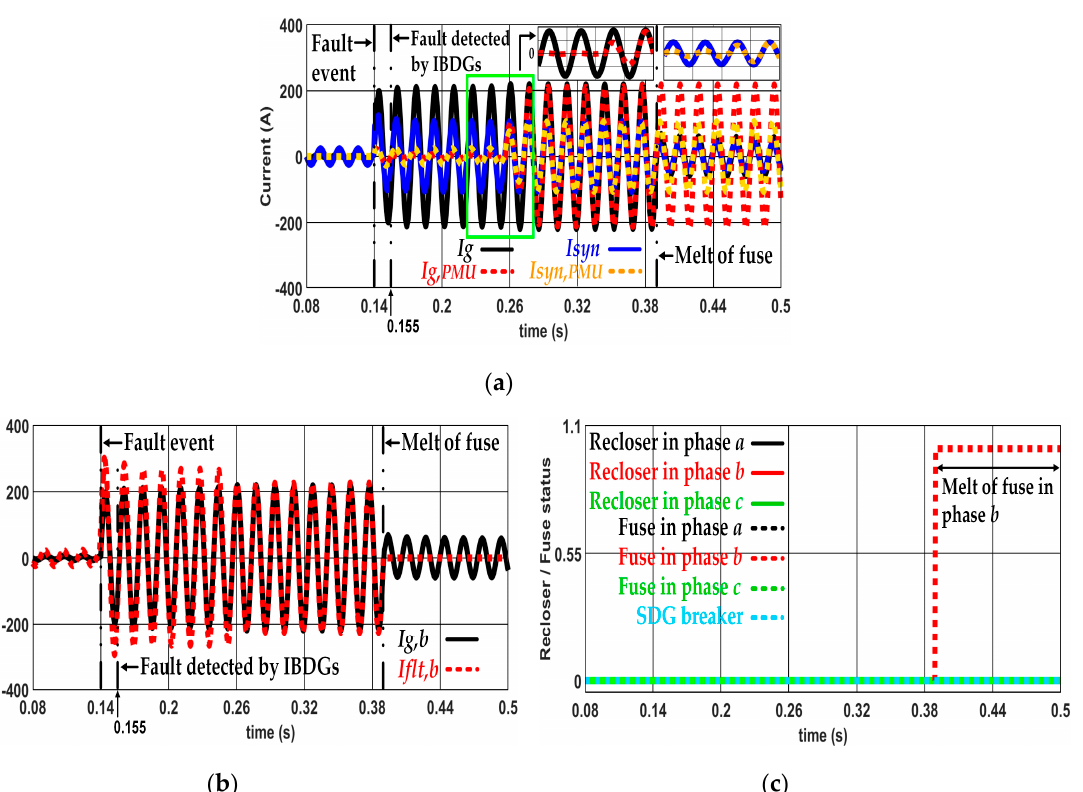
Figure 8. Effect of delay caused by using phasor measurement units (PMUs) on separated phase–current controls: ( a ) real-time currents and currents calculated by PMU data; ( b ) total fault current and grid current; ( c ) operating time of recloser–fuse and Synchronous distributed generators (SDG) breaker.